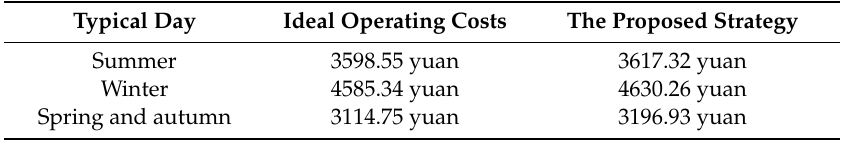
Table 5. The operating costs and ideal operating costs of the algorithm proposed in this